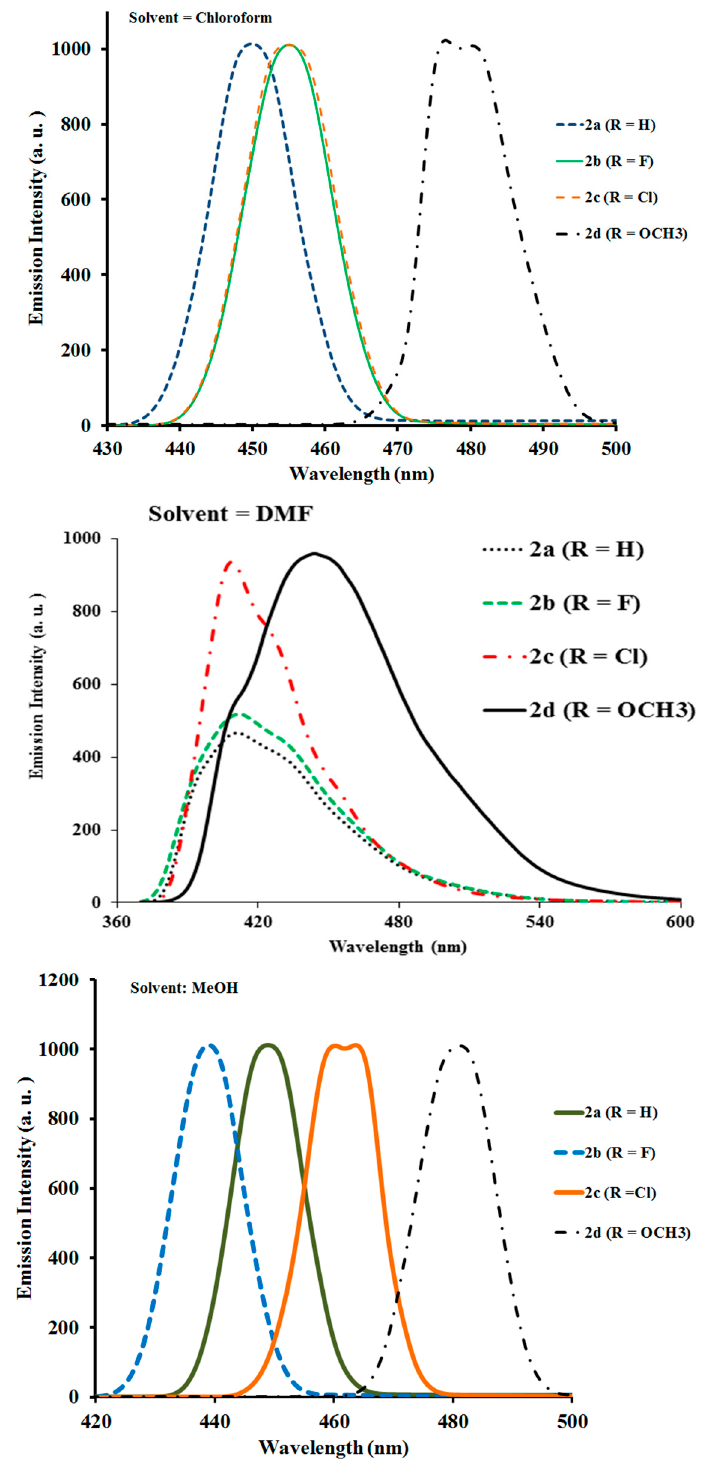
Figure 3. Fluorescence emission spectra of 2a – d (concentration 2.0 × 10 − 7 mol/L) at RT (room temperature).